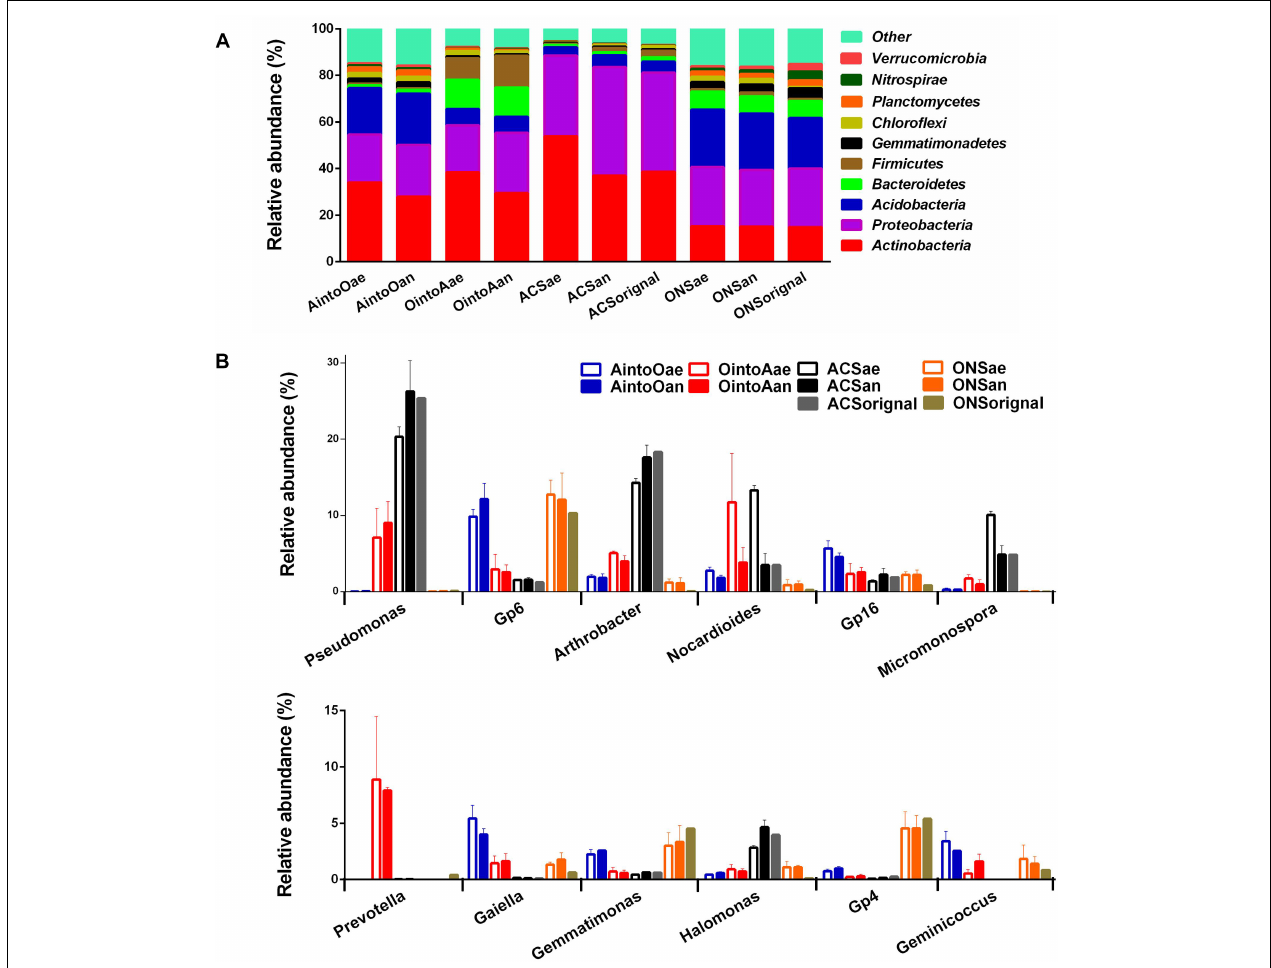
FIGURE 1 | Community compositions of different treatments after incubation. (A) Relative abundances of predominant phyla in the samples of different treatments. (B) Relative abundance of predominant genera in the samples of different